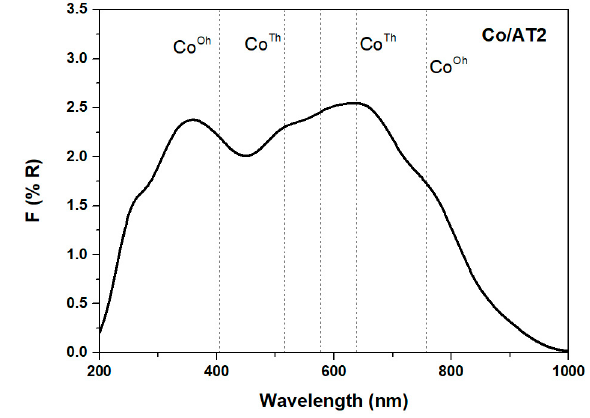
Figure 7. DR UV-vis spectra of the Co / AT2 calcined at 673 K.